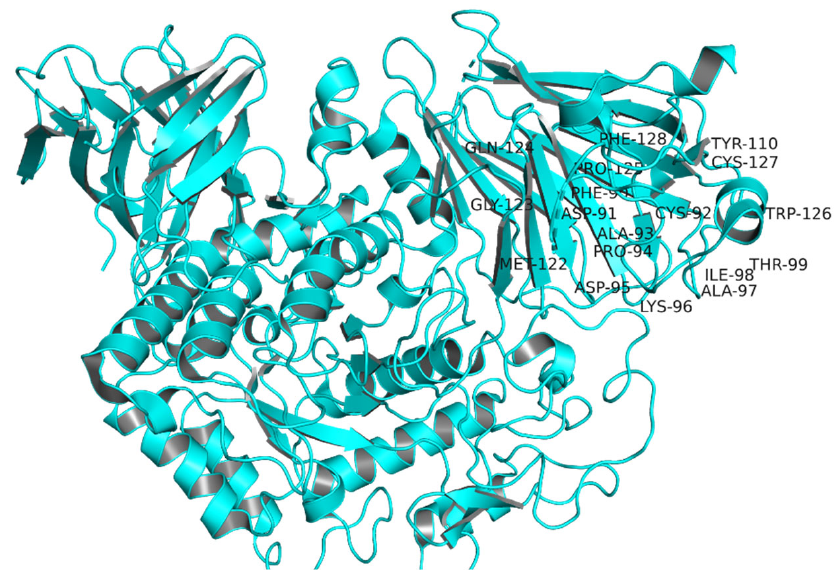
Figure 5. Active site residues of target protein identified via literature and CastP.